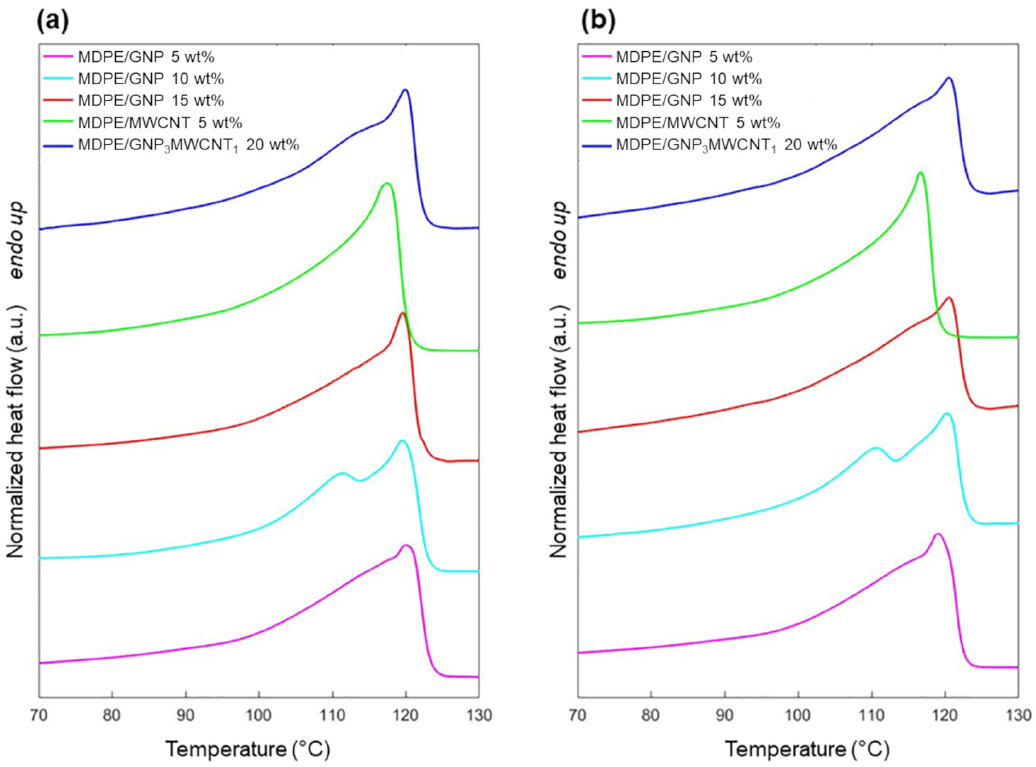
Figure 5. DSC thermograms upon heating for MDPE/GNP 5 wt%, MDPE/GNP 10 wt%, MDPE/GNP 15 wt%, MDPE/MWCNT 5 wt% and MDPE/GNP 3 MWCNT 1 20 wt% nanocomposites ( a ) before and Data are o ff set for clarity.